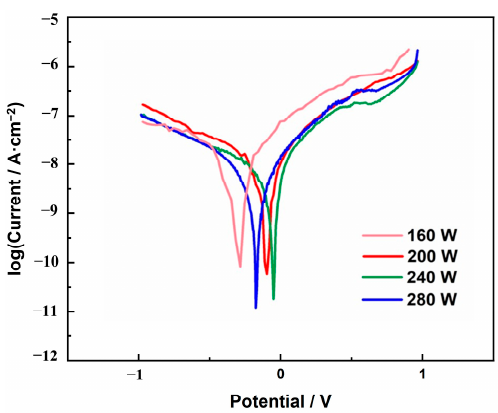
Figure 5. Polarization curves of Ti6Al4V alloy at scanning rate of 1200 mm/s. Table 1. Corrosion potential and current density of Ti6Al4V alloy in SBF at scanning rate of 1200 mm/s.